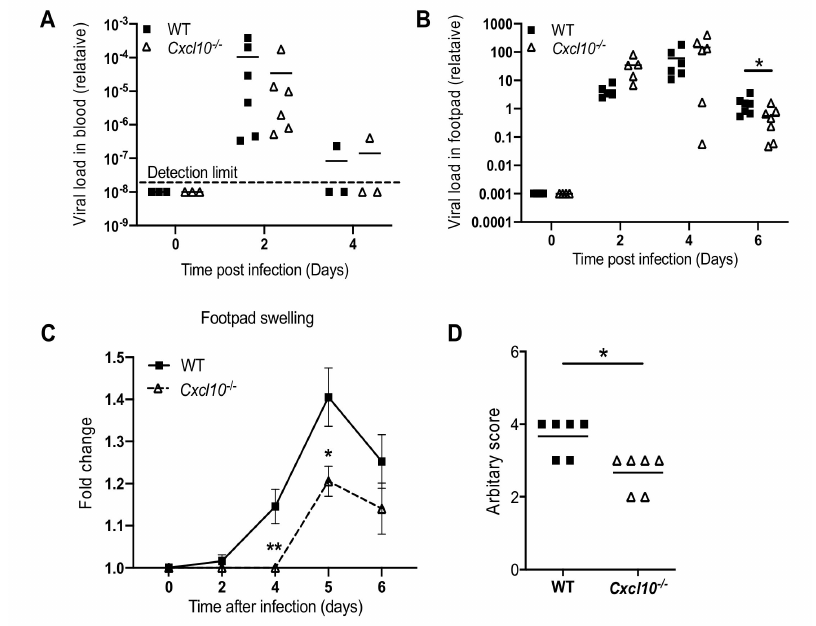
Figure 3. CXCL10 signaling facilitates O’nyong-nyong virus (ONNV_ pathogenesis in mouse feet. Age- and sex-matched C57BL / 6 (WT) and Cxcl10 -deficient ( Cxcl10 − / − ) mice were infected with ONNV. ( A ) qPCR quantification of ONNV loads in ( A ) whole blood cells and ( B ) the footpads at various days after infection. ( C ) Fold changes in the footpad dimensions of ONNV-infected mice (Days 2, 4, 5, and 6) in comparison to the uninfected mice (Day 0) ( n = 7 per genotype). Error bar: mean ± s.e.m. * p < 0.05, ** p < 0.01, two-tailed Student’s t-test. ( D ) Arbitrary scores of ankle joint inflammation